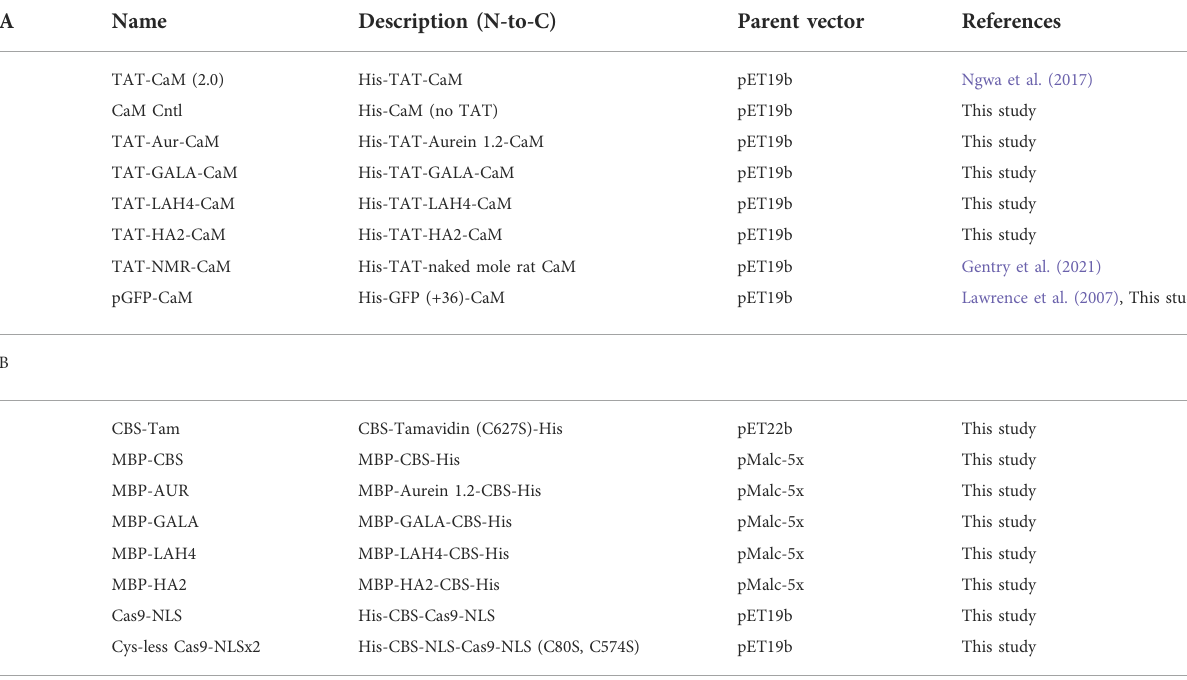
TABLE 1 Schematic descriptions of proteins used in this study; A, CPP-adaptors and adaptor controls; B, cargo proteins. Additional details including amino acid sequences, spacers and tags are described in Supplementary Information. A